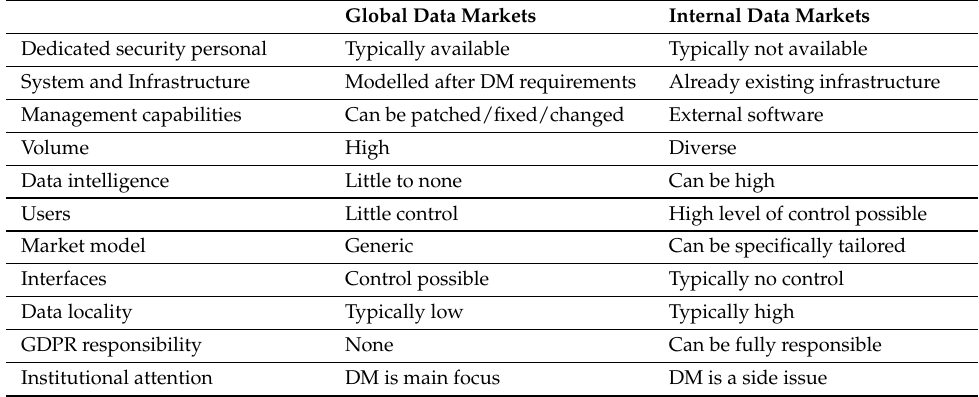
Table 1. Security-related key differences between internal and global data markets. Global Data Markets Internal Data